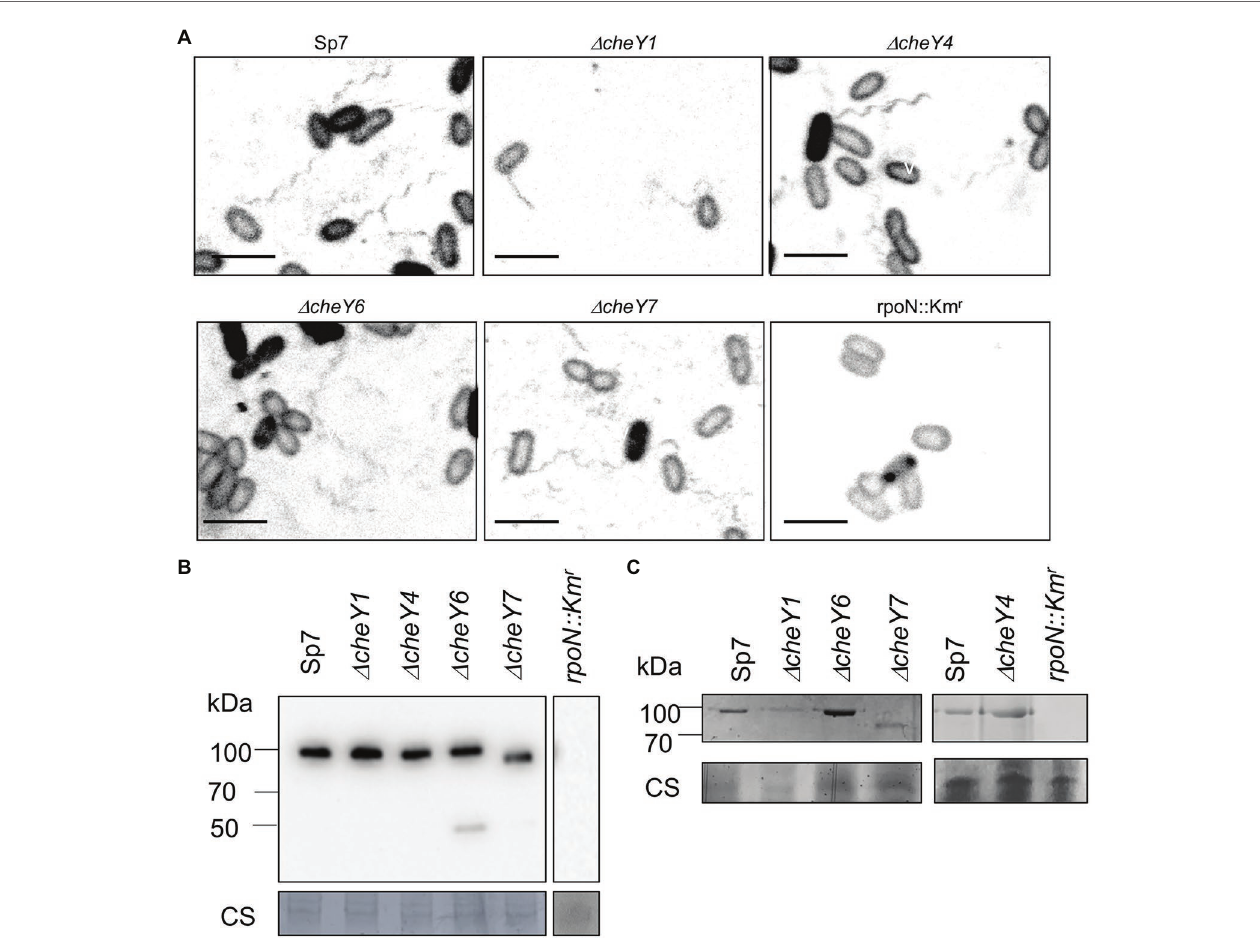
FIGURE 3 | Visualization of the polar flagella in A. brasilense strains. (A) Representative images of Sp7, ΔcheY1 , ΔcheY4 , ΔcheY6 , and ΔcheY7 cells with polar flagella stained with Alexa fluor ™ 488 NHS Ester. A rpoN::Km r mutant which is aflagellate and non-motile was used as a negative control. Images are presented as the negatives of the original images. Scale bar = 5 μ m. (B) Western blot analysis with anti-polar flagellin (1:1,000) polyclonal antisera of whole-cell preparations of A. brasilense Sp7, ΔcheY1 , ΔcheY4 , ΔcheY6 , ΔcheY7 , and rpoN::Km r mutants grown in liquid media. Coomassie staining is shown below for an evaluation of loading control. (C) Glycoprotein staining of polar flagellin produced by wild type Sp7 and ΔcheY1 , ΔcheY4 , ΔcheY6 , and ΔcheY7 cells ΔcheY1 , ΔcheY4 , ΔcheY6 , and ΔcheY7 mutants. rpoN::Km strain was used as the negative control. The black lines indicate junctions separating lanes that were spliced from the original image in order to show samples run on the same gel in a single